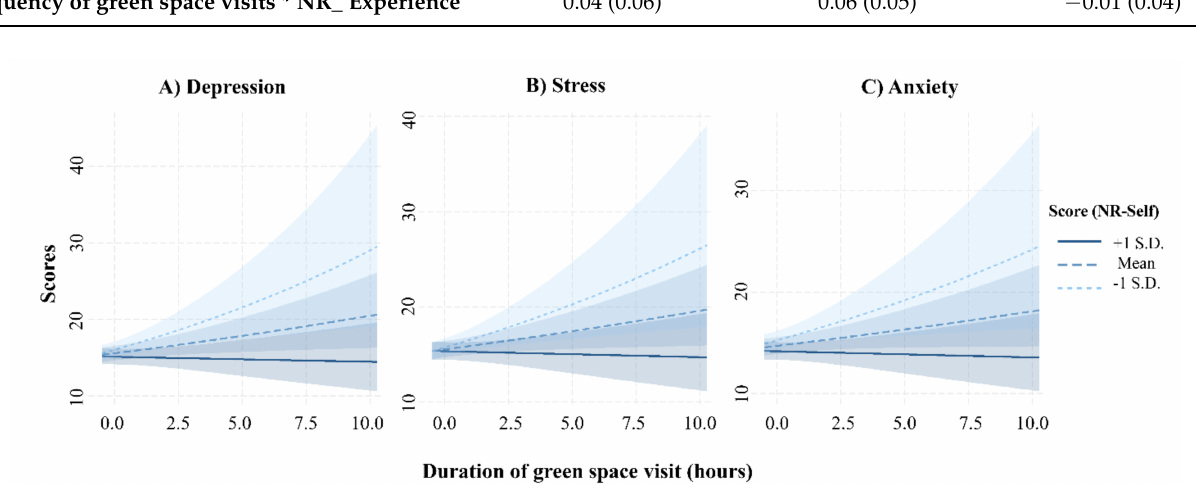
Figure 1. Interaction plots from the mixed-effects model showing the relationship between duration of nature interaction with each mental wellbeing score—( A ) depression; ( B ) stress; and ( C ) anxiety. Fitted lines represent the mean, +1 standard deviation (S.D.), and − 1 standard deviation scores for ecological identity (i.e., nature relatedness—self). Shaded area represents confidence